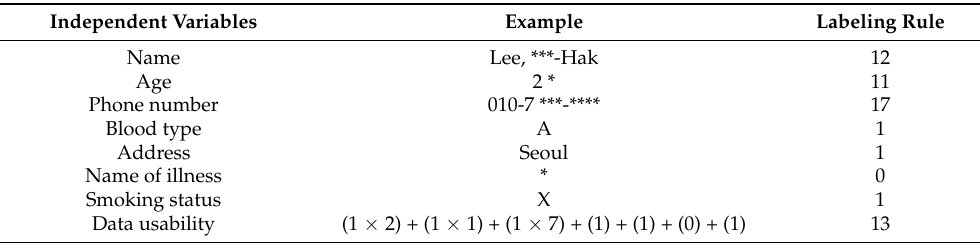
Table 5. Example of calculation for data usability. An asterisk (*) indicates a de-identified character from personal information.